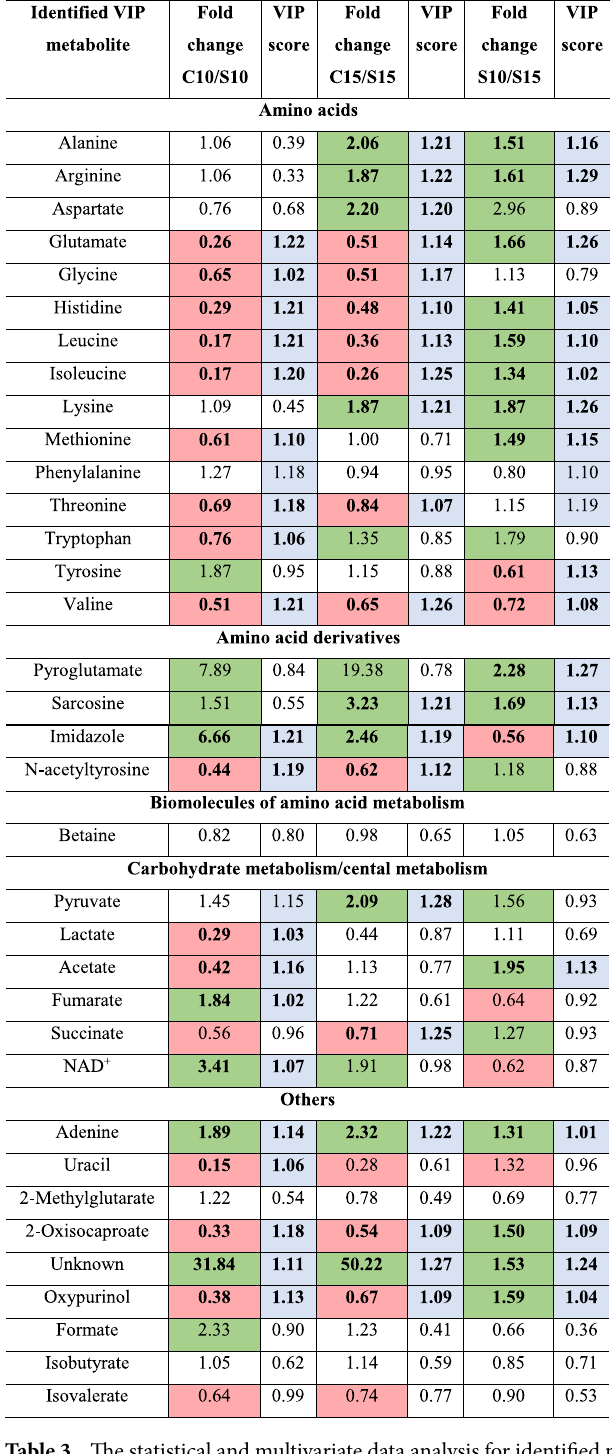
Table 3. The statistical and multivariate data analysis for identified metabolites before and after multiple sub- lethal exposures of A. baumannii to aPDT (increased levels of metabolites with p value < 0.05 are marked in red; decreased levels of metabolites with p value < 0.05 are marked in green; VIP values > 1.00 are marked in grey; metabolites with p value < 0.05 and VIP value > 1.00 are bolded). C10 or C15- cultures before phototherapies, after ten or fifteen inoculations (controls). S10 or S15- cultures after ten or fifteen sub-lethal